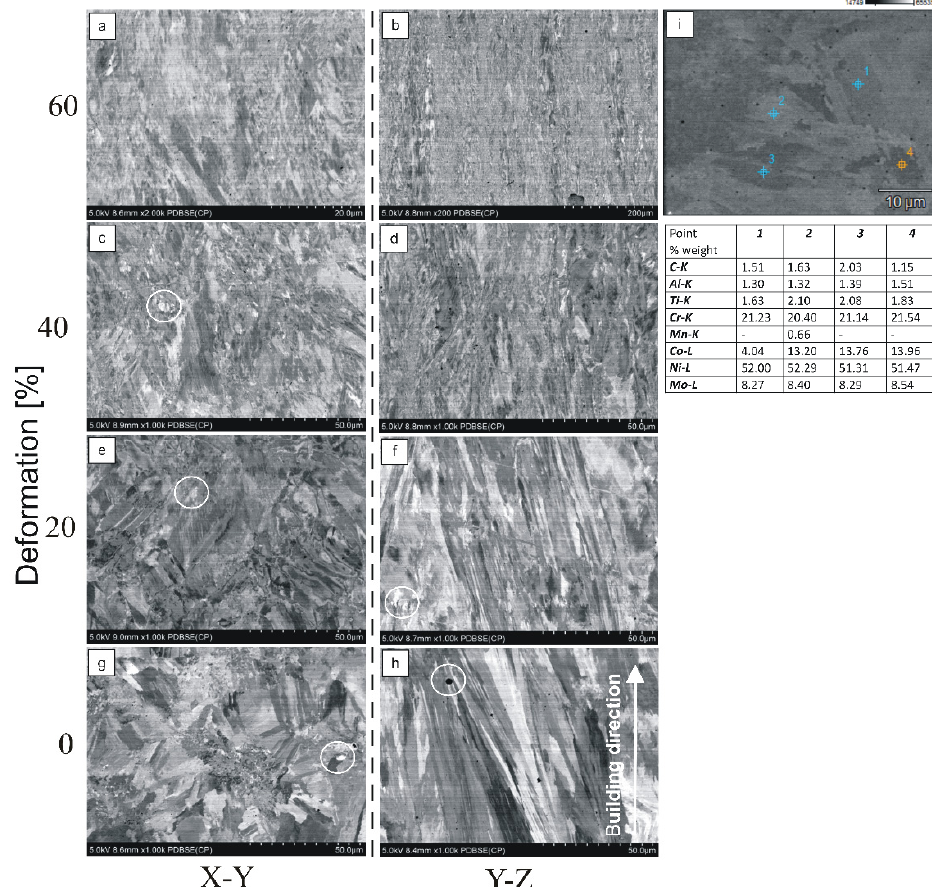
Figure 6. Microstructure of DMLS samples depending on the construction direction and point analysis of the chemical composition. ( a ) 60% deformation, cross section; ( b ) 60% deformation, longitudinal section; ( c ) 40% deformation, cross section; ( d ) 40% deformation, longitudinal section; ( e ) 20% deformation, cross section; ( f ) 20% deformation, longitudinal section; ( g ) initial state, cross section; ( h ) initial state, longitudinal section; ( i ) point analysis of the chemical